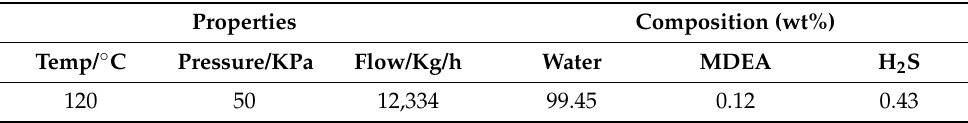
Table 2. The properties and composition of the Table 1. The chemical components of the 20# steel.